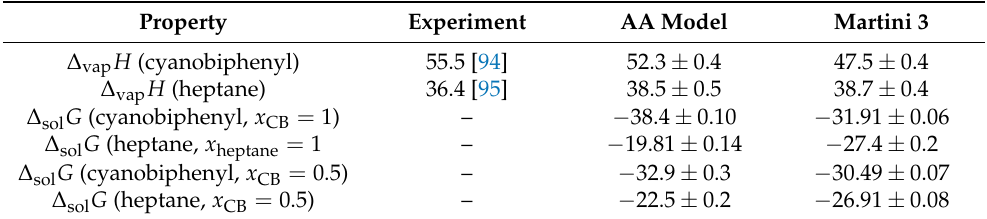
Table 1. Enthalpies of vaporization ( ∆ vap H /kJ mol − 1 ) and free energies of solvation ∆ sol G /kJ mol − 1 ) for all-atom GAFF (AA) and Martini 3 CG models of cyanobiphenyl/heptane mixtures.